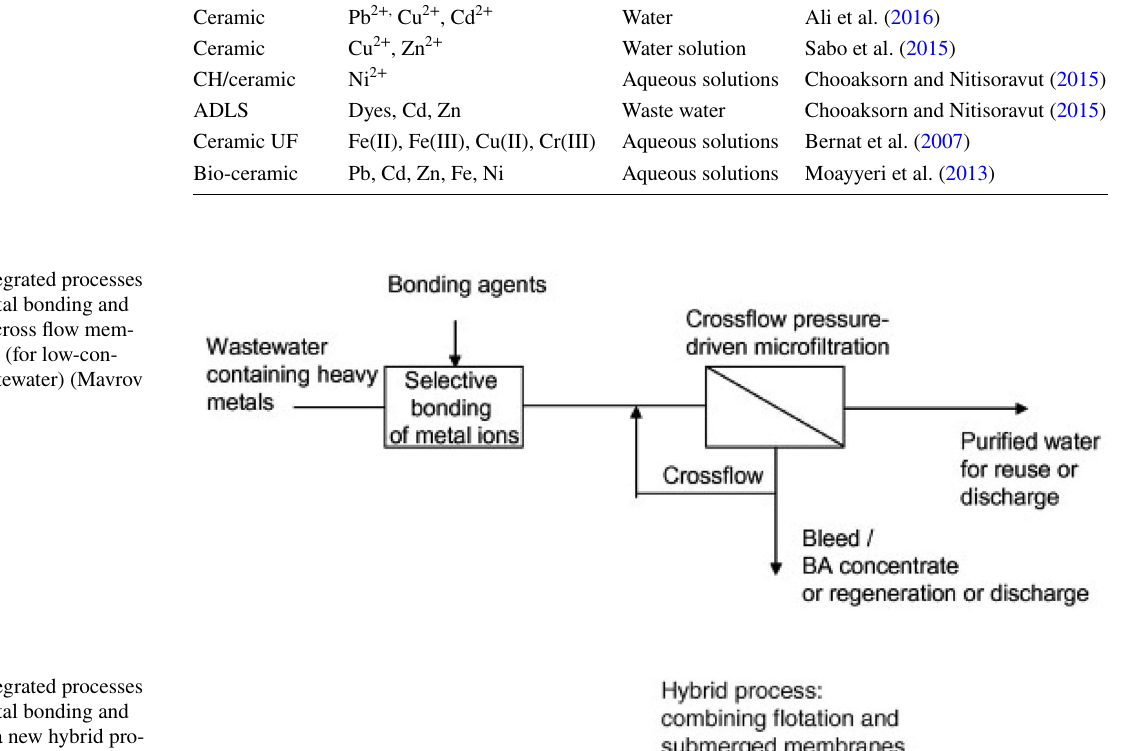
Table 4 Summary for heavy metal separation by ceramics/ membranes material for the heavy metal separation